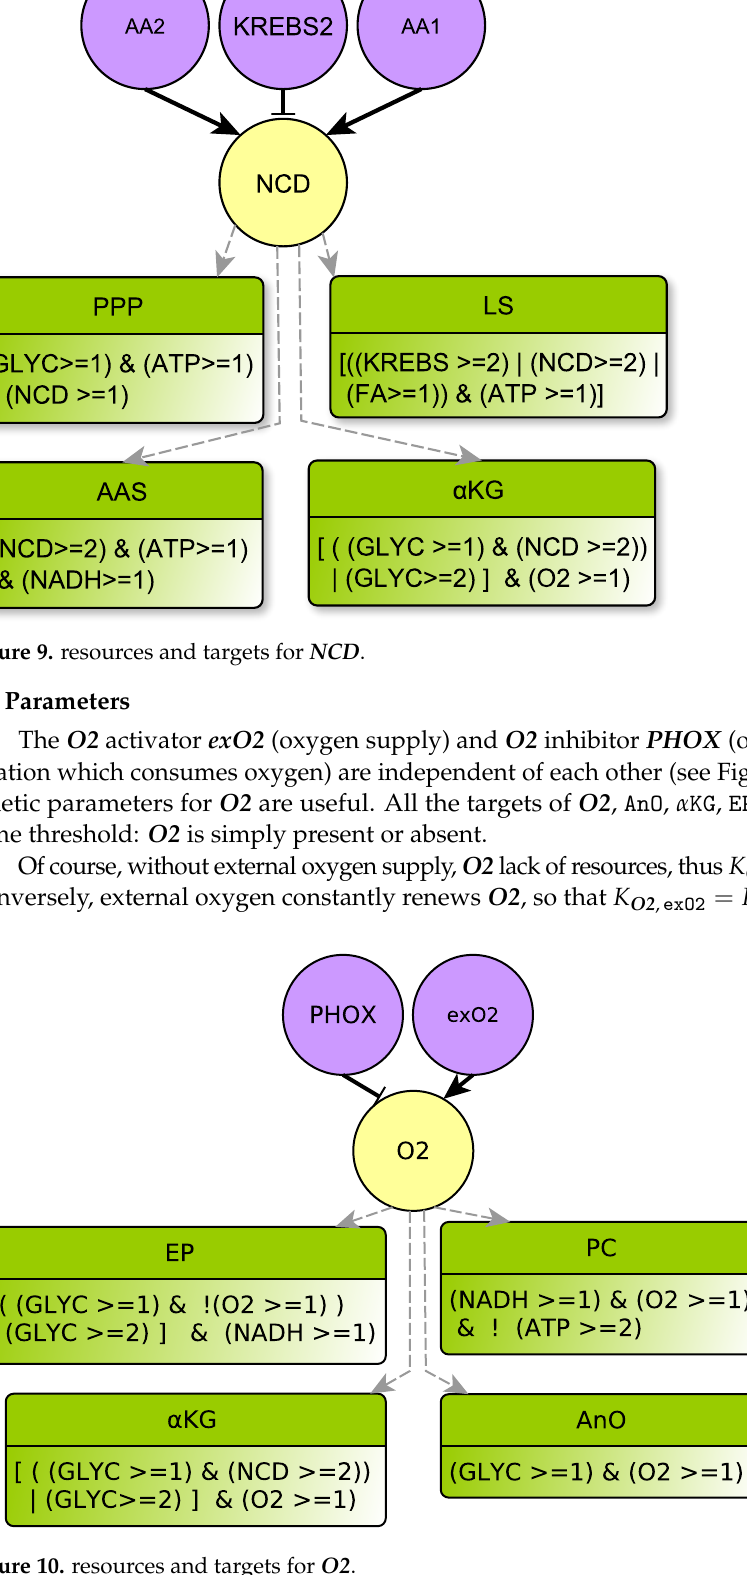
Figure 10. resources and targets for O2